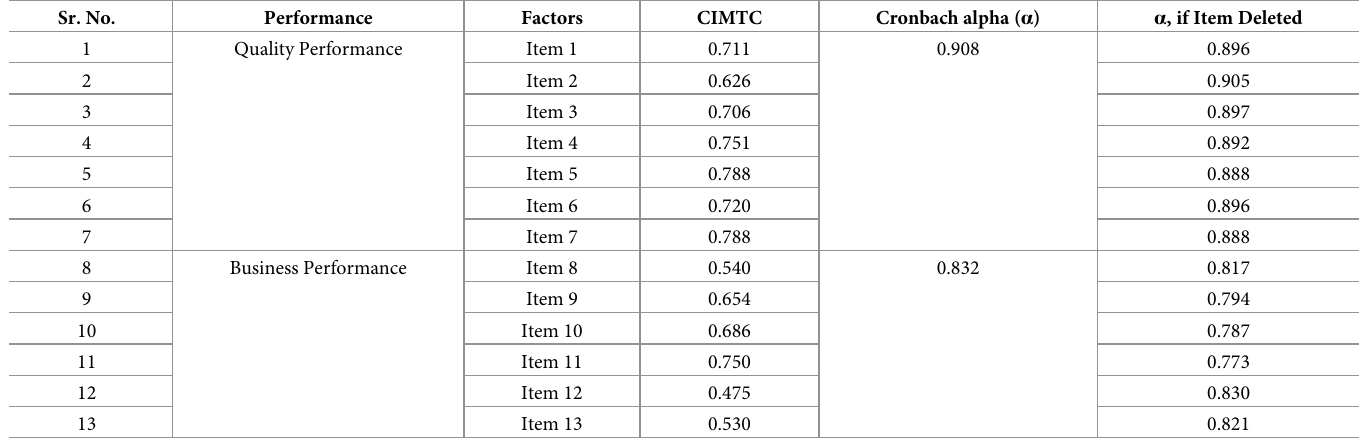
Table 6. Reliability testing for performance of hospitals. Sr.